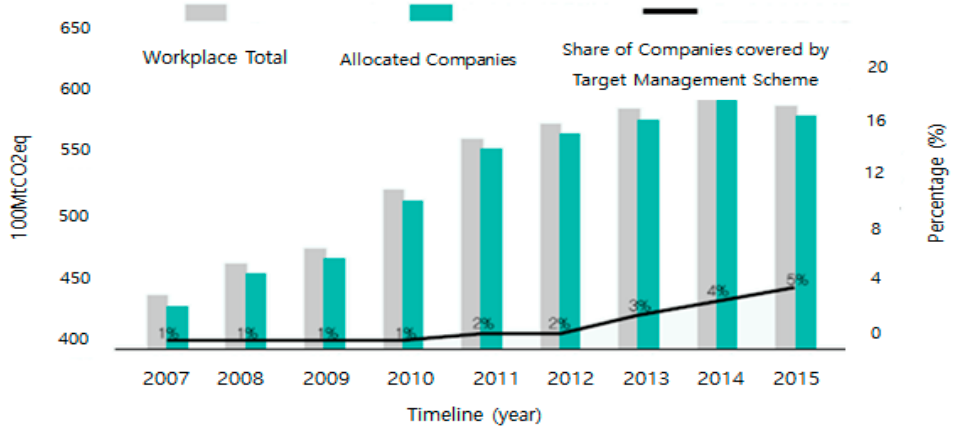
Figure 3. Emission trends in workplaces and allocated companies. Source: GIR. Available online: https://www.gir.or.kr/ (accessed on 27 April 2017).